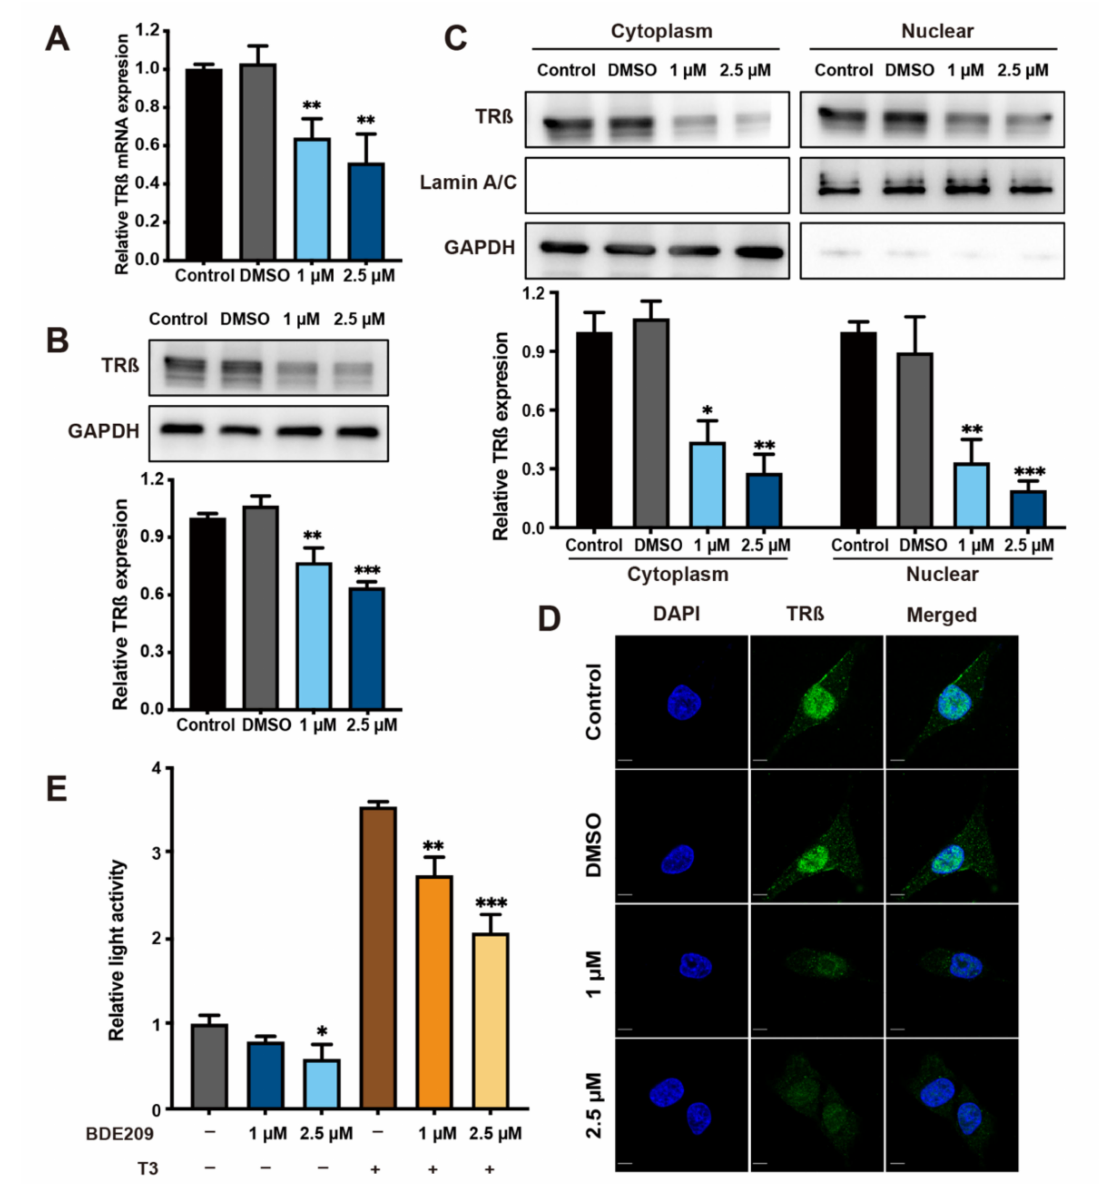
Figure 4. BDE209 promotes tumourigenesis by inhibiting TRß expression and function. ( A ) Nthy-ori 3-1 cells were treated with 1 and 2.5 µ M BDE209 for 27 days and compared with negative controls. TRß mRNA levels were detected at the indicated time points by qRT–PCR. ( B ) Nthy-ori 3-1 cells were treated with 1 and 2.5 µ M BDE209 for 27 days. After the cells were harvested, the whole lysates were subjected to Western blotting. Upper panel: Representative images of Western blotting. Bottom panel: Quantitative results of Western blotting from triplicate experiments. ( C ) Cytoplasmic and nuclear TRß protein levels were analysed in Nthy-ori 3-1 cells. GAPDH and Lamin A/C were used as cytoplasmic and nuclear protein-loading controls, respectively. Quantitative results of Western blotting from triplicate experiments are shown at the bottom. ( D ) TRß (green) localization after treatment with different doses of BDE209 was determined using immunofluorescence staining. All pictures were imaged using a confocal microscope. Representative images are shown with a 10 µ m scale bar. ( E ) The plasmids pTRE-Luc and pRL-TK were cotransfected into 293T cells. The cells were incubated with or without 0.1 µ M T3 and BDE209 for 48 h. Data are the mean ± SD of experiments performed in triplicate. * p < 0.05, ** p < 0.01, and *** p < 0.001. Each experiment was repeated at least three